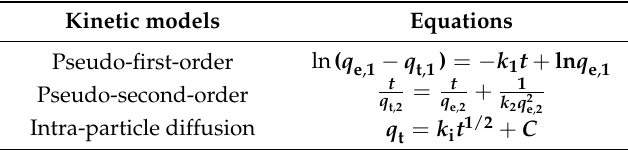
Table 1. Equations of adsorption kinetic models.